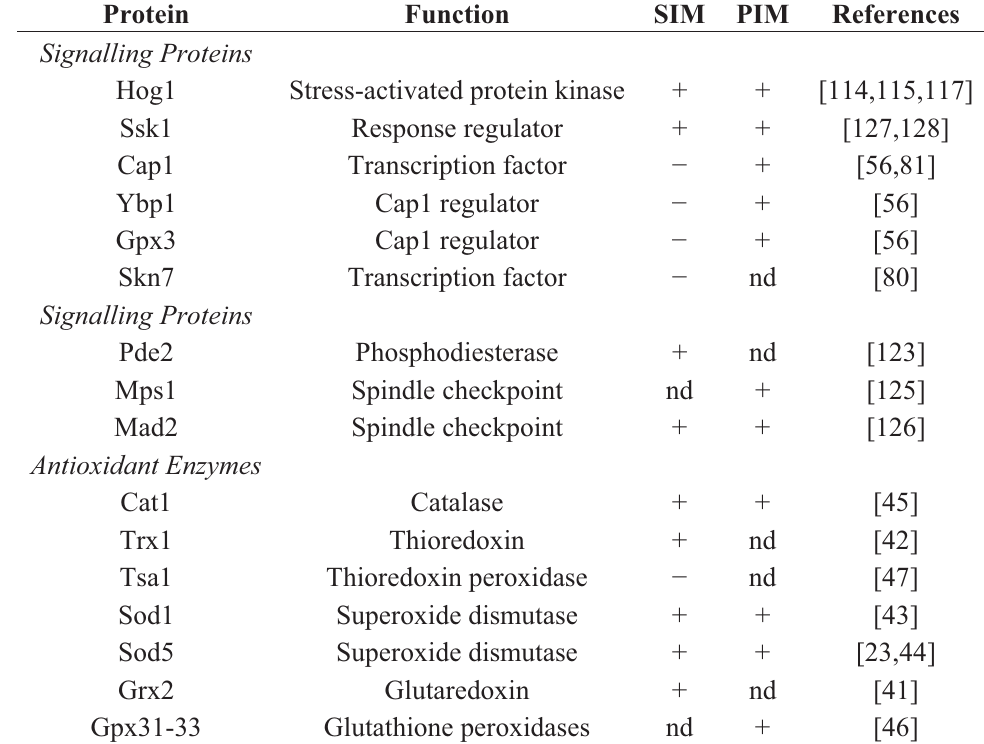
Table 1. Summary of the role of oxidative stress-responsive signalling proteins and antioxidant enzymes in C. albicans virulence. The importance of proteins needed for resistance to oxidative stress in mediating C. albicans virulence in either a systemic infection model (SIM) or phagocyte infection model (PIM) is indicated; +, important for virulence; (cid:2), dispensable for virulence; nd, not determined. For further explanation, see the